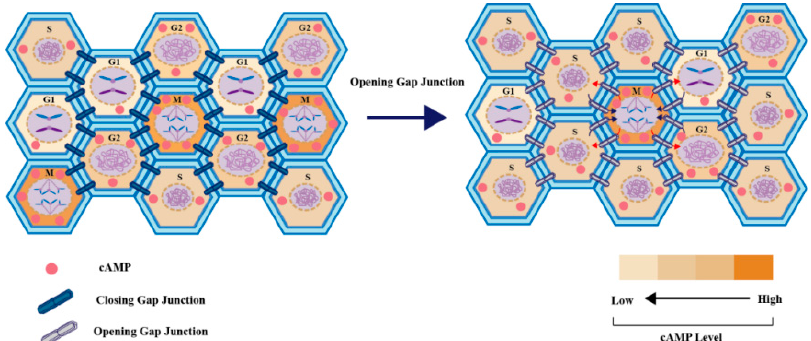
Figure 3. Gap junction-mediated transfer of cAMP limits the rate of mitosis of the whole tumor cell population. Changes in cAMP levels alter PKA activity to regulate cell cycle progression. Low levels of PKA activity help cells progress through the G1 and S phases to interphase. However, high levels of PKA activity are needed for cells to enter and exit the mitotic cycle. In the absence of gap junction-mediated communication, different cAMP levels in each cell result in different cell cycle stages in the population. However, the cell groups that maintain communication throughout the cell cycle exhibit a uniform distribution of cAMP, thereby, resulting in the dilution of cAMP (and decrease in P-PKA) in M-phase cells (leading to the inhibition of mitotic processes) and an increase in cAMP and PKA activity in G1/S-phase cells (leading to partial G1 phase arrest). Thus, cAMP redistribution delays the M phase and cell cycle progression through the interphase